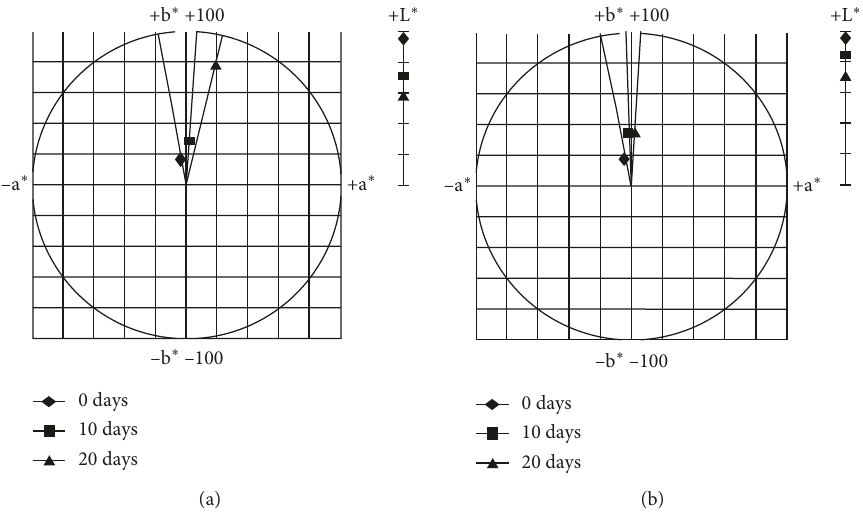
Figure 1: Chromatism of tea infusion during storage. (a) Conventional extraction. (b) Extraction with β -CD. Tea infusion extracted with or without β -CD was stored at 4 ° C for 20 days. The samples were analyzed for lightness (L), redness (+a), greenness ( blueness ( b). Measurements were conducted on a total of 5 samples for each −